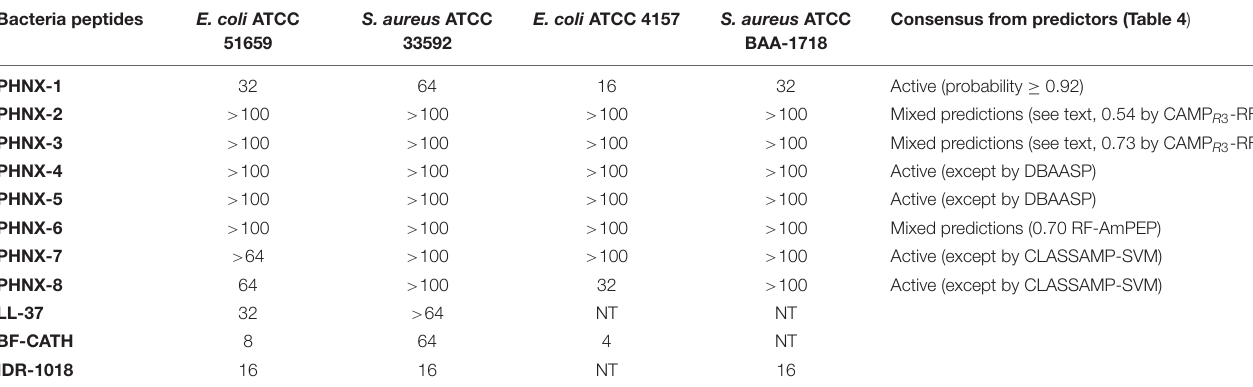
TABLE 5 | Minimum inhibitory concentration (MIC) of PHNX peptides ( µ g/ml) against multi-drug resistant and antibiotic susceptible strains of E. coli and S. aureus . Bacteria peptides E. coli ATCC S. aureus ATCC E. coli ATCC 51659 33592